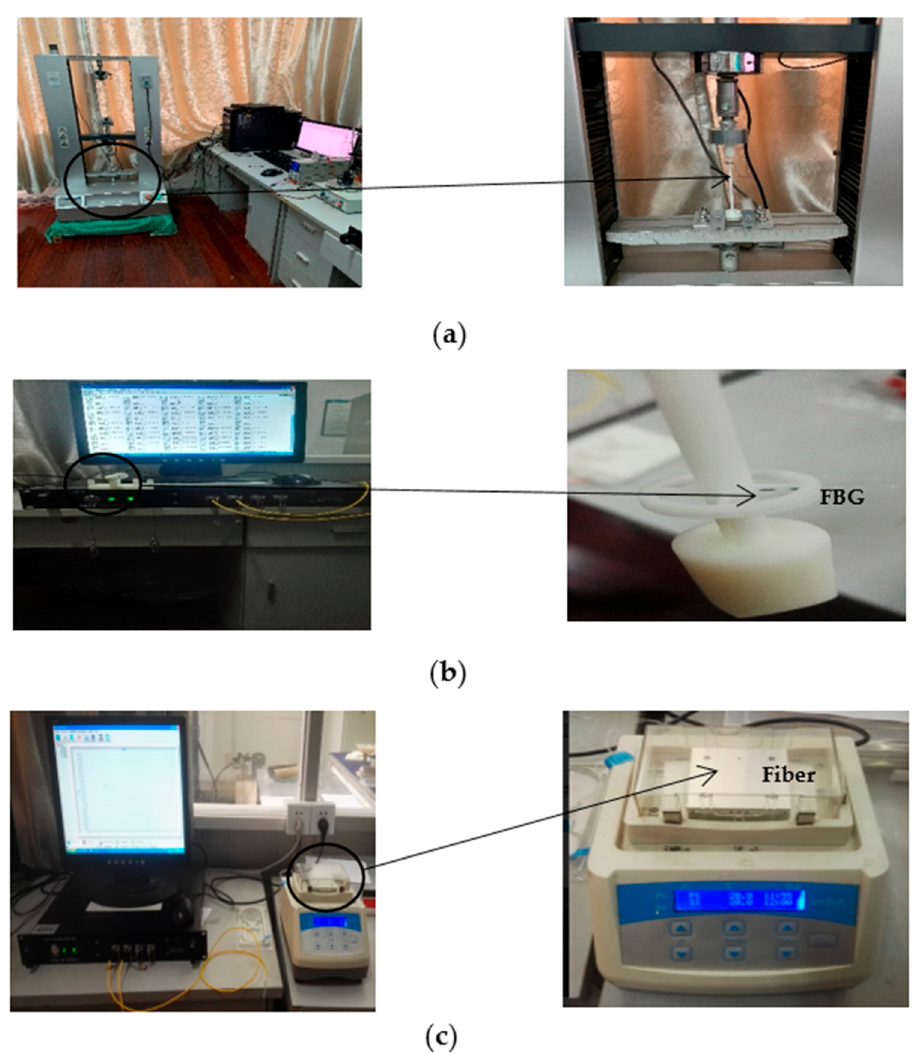
Figure 11. The experimental setup: ( a ) Axial force calibration experiments; ( b ) Torque force calibration experiments; ( c ) Temperature calibration